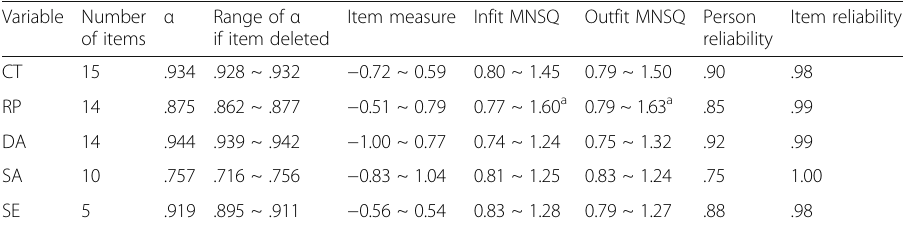
Table 1 The psychometrical properties of the used instruments α Range of α Variable Number Item measure Infit MNSQ Outfit MNSQ Person of items if item deleted